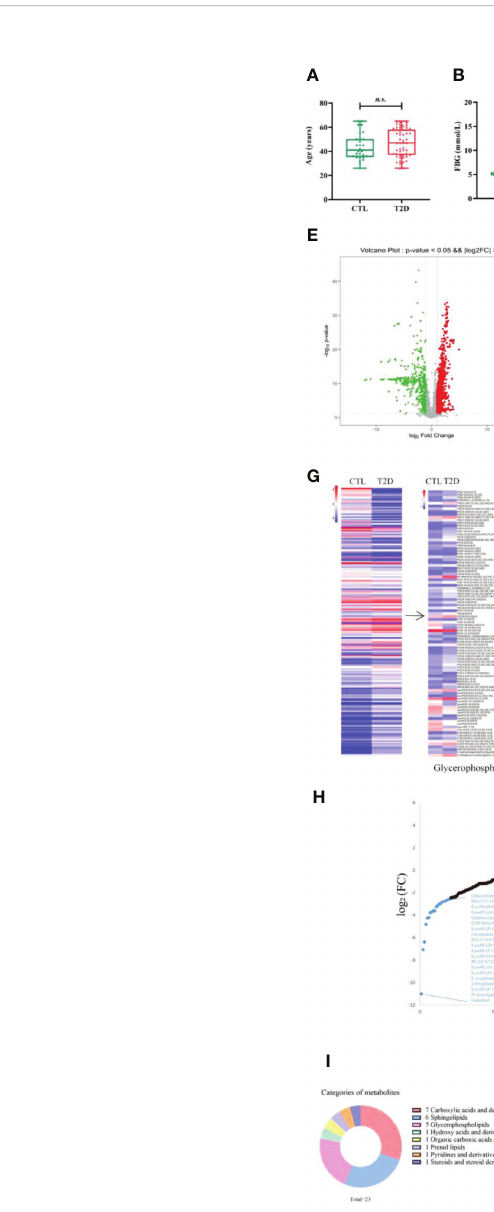
FIGURE 3 Change in metabolic signatures and metabolite groups at the early stage of diabetes development. The levels of age (A) , FBG (B) , HbA1c (C) and HOMA2% b (D) in controls (n = 28) and in patients with T2D at baseline (n = 52). Differences between the T2D group and the CTL group were tested by independent sample t test (normally distributed variables) **p < 0.01. n.s. the difference is not statistically signi fi cant. (E) Volcano plot showing -log 10 p-value against log 2 -fold change of 198 metabolites in T2D cases versus controls. (F) Hierarchical cluster analysis of differential metabolites in T2D at baseline, compared to the CTL group. (G) Comparison of the differential metabolites between the T2D and CTL groups. Fold changes are log transformed and indicated by color scale in matrix. (H) Plot shows the top 15 increased (red) and decreased (blue) metabolites in T2D. (I) The categories of the 23 metabolites signi fi cantly associated with FBG (correlation coef fi cient >0.7). (J) The values of three main categories of FBG-associated metabolites are plotted with a Loess curve against the FBG. FBG, fasting blood glucose; HbA1c, glycated hemoglobin; HOMA2% b , the Homeostasis Model Assessment (HOMA) estimates steady state beta cell function (% b